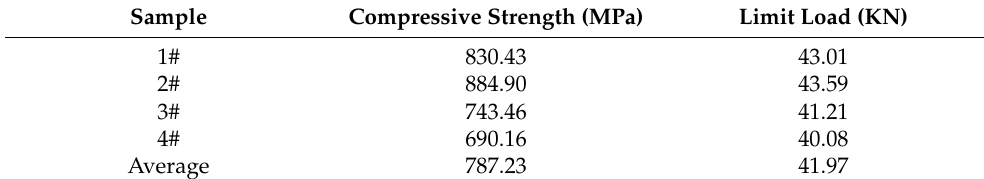
Figure 4. Limit load–displacement curve. Table 2. Laminate tensile test results data.